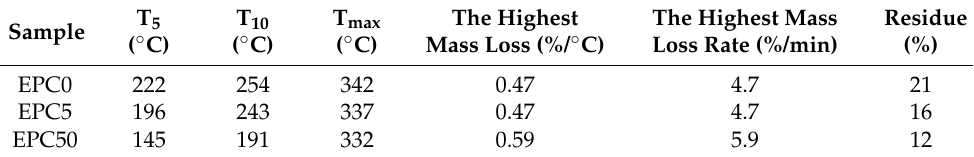
Figure 6. TGA curves of the EPC0, EPC5, and EPC50 foams. Table 6. TGA results of the EPC0, EPC5, and EPC50